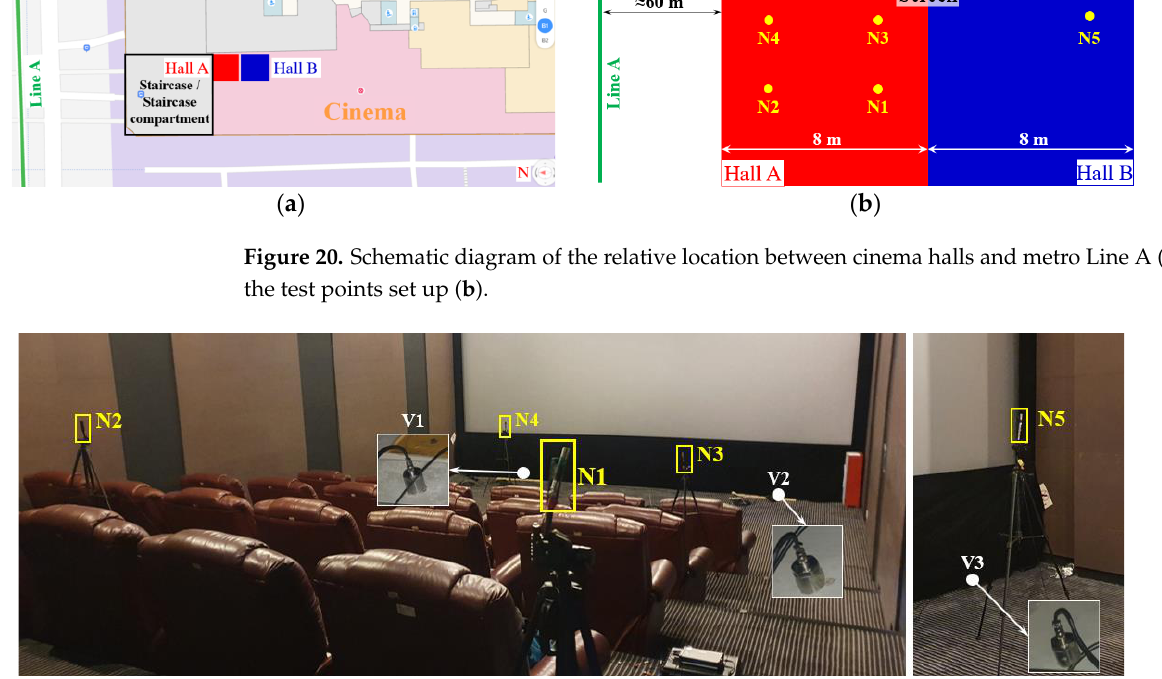
Figure 22. The 1/3 octave frequency division vibration acceleration levels in the cinema.